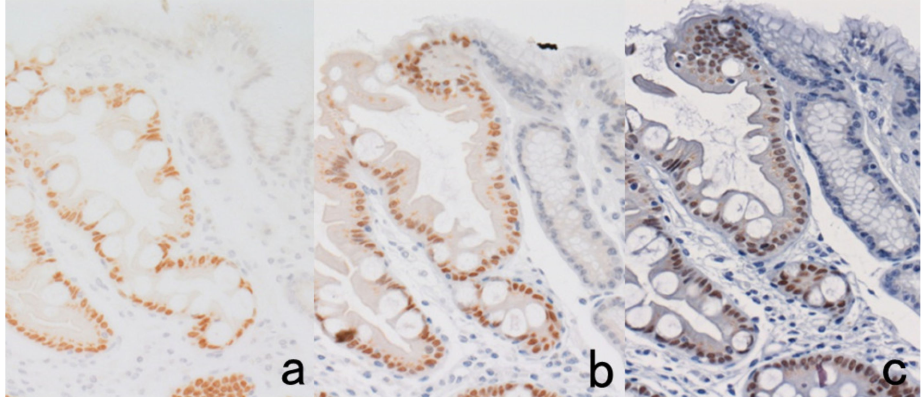
Figure 39. Poor nuclear stainability by hematoxylin after EDTA-mediated HIER. CDX2 (a nuclear marker for intestinal-type epithelial cells) immunoreactivity in intestinal metaplasia of the stomach. Mayer’s hematoxylin staining for 10 s ( a ), 1 min ( b ), and 3 min ( c ). Prolonged nuclear staining is necessary after HIER in 1 mM EDTA solution, pH 8.0.